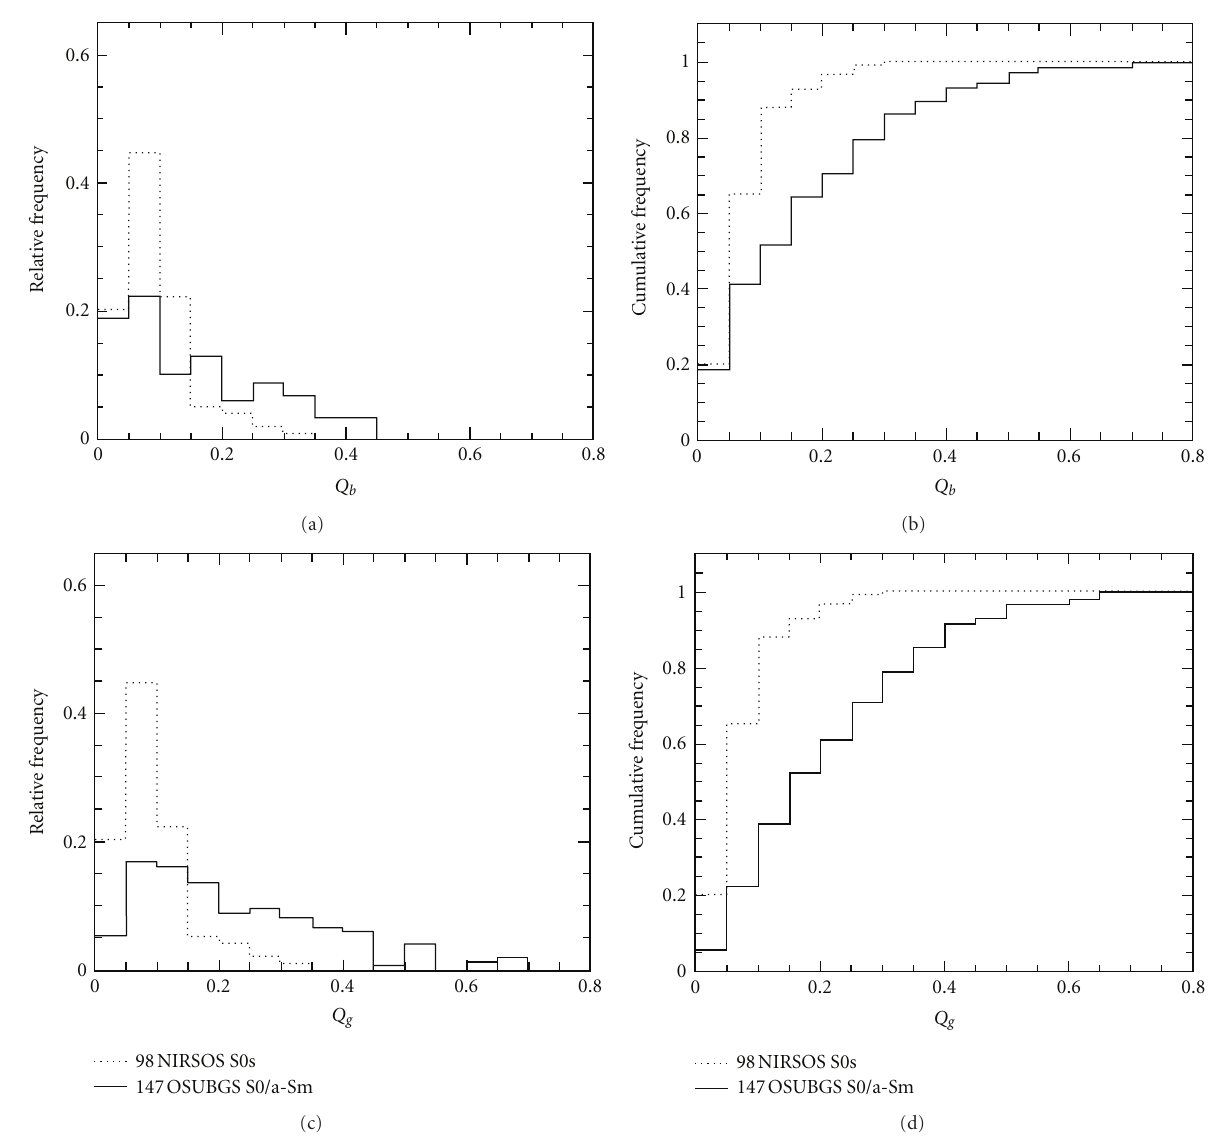
Figure 13: Histograms of the distribution (a) and (c) and cumulative distribution (b) and (d) of bar strengths in S0 (dotted line) and spiral galaxies (full line). This figure shows that bars are weaker in S0 than in spiral galaxies. Credit: Buta et al. [190]. Reproduced by permission from the